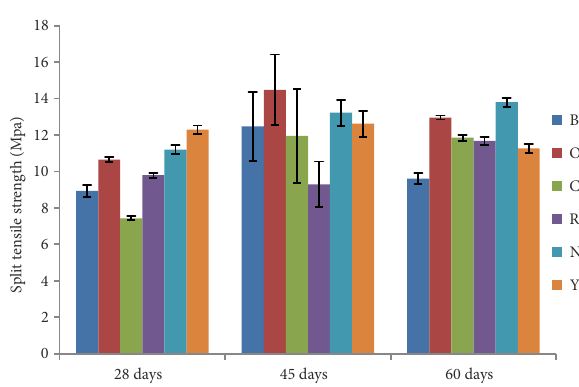
Fig. 5. Split tensile strength test at 28, 45 and 60 days (source: created by the author Akinyemi